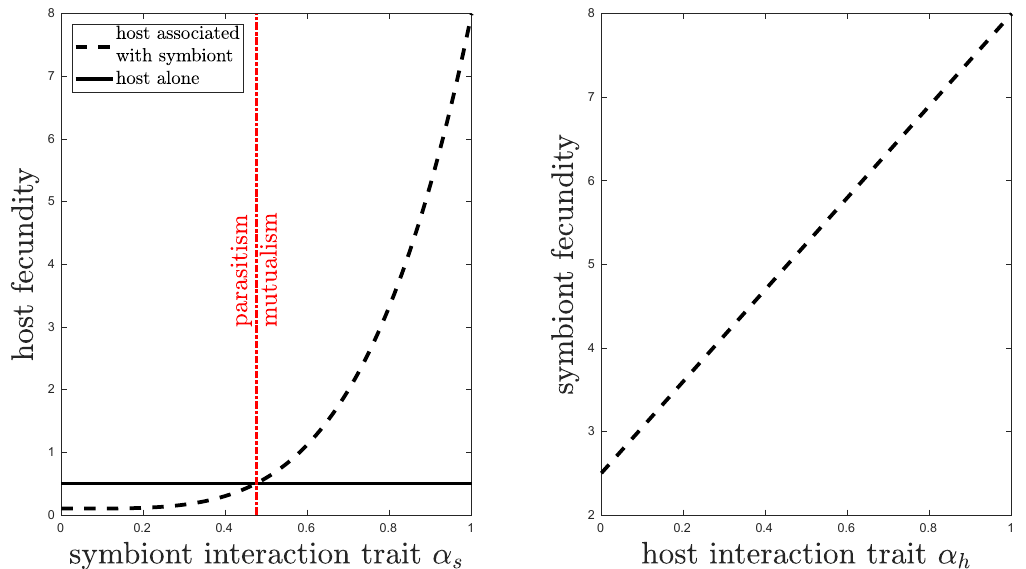
h s and symbionts f according to the interaction trait of their partners (dashed Figure 1. Fecundity of hosts f a black lines). Plain black line corresponds to the fecundity of a solitary host f . The dashed red line in panels (a) and (b) corresponds to the threshold α ∗ s = 0 . 475 separates symbionts, which either reduce or enhance the fecundity or their host (appendix